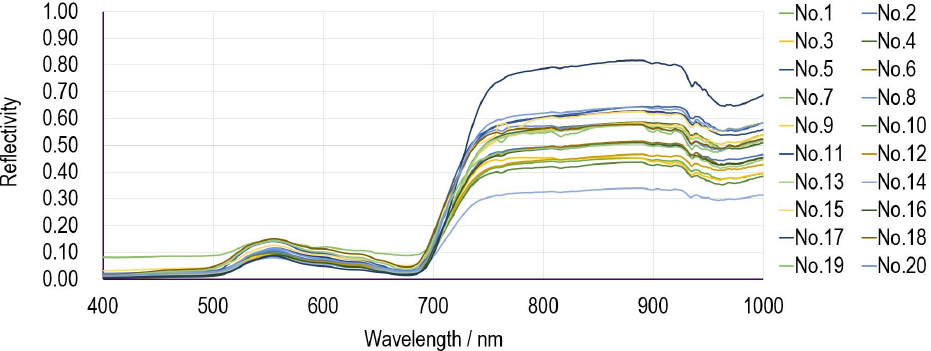
Figure 3. Canopy reflectance data of 20 mangrove sampling points collected by hand-held spectrometer. Table 2. Spectral transformation methods and calculation formulas. The collected spectral data are processed by a series of spectral transformations to highlight the effective information expression in the spectral